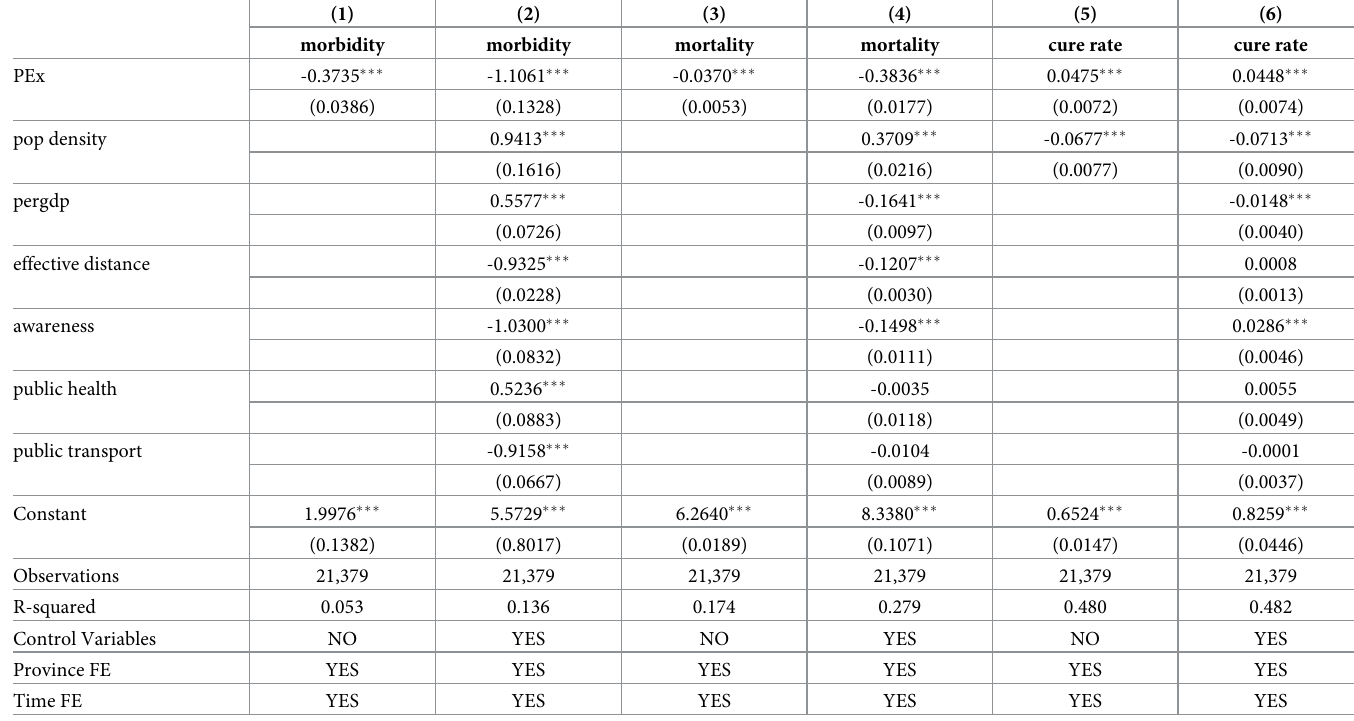
Table 2. Baseline